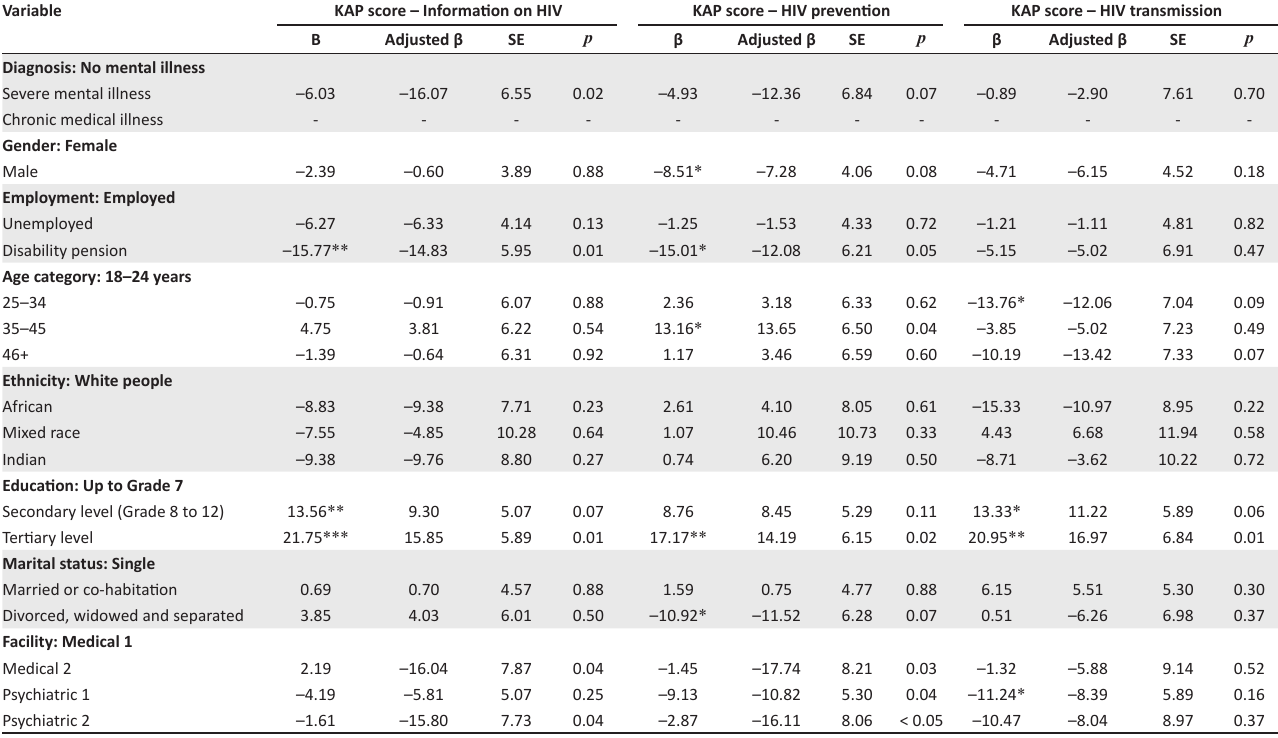
TABLE 4: Sociodemographic and clinical comparison of participant knowledge, attitudes and practices to HIV responses.